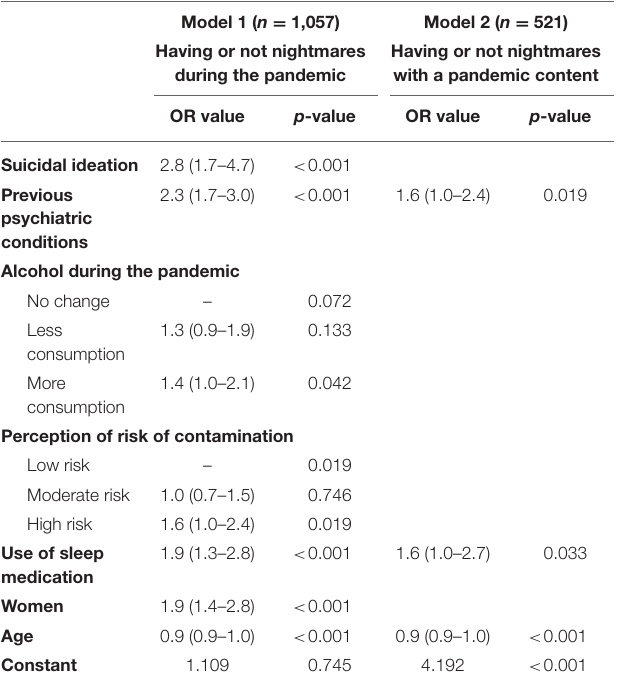
TABLE 5 | Independent factors associated with the occurrence of nightmares and pandemic nightmares.